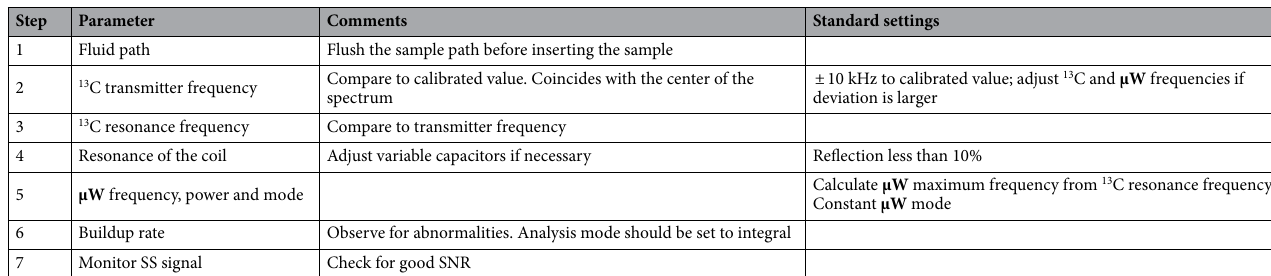
Table 3. Routine DNP procedure conducted before and during each DNP experiments.